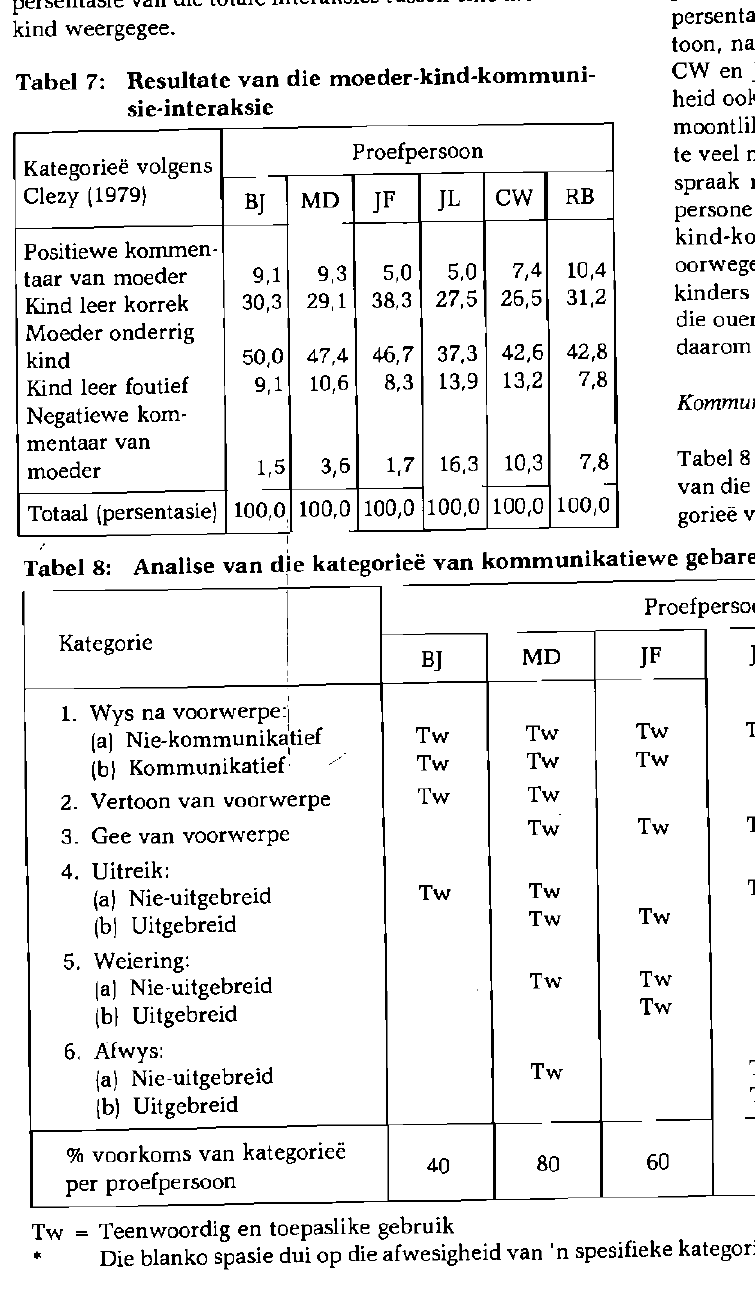
Tw = Teenwoordig en toepaslike gebruik